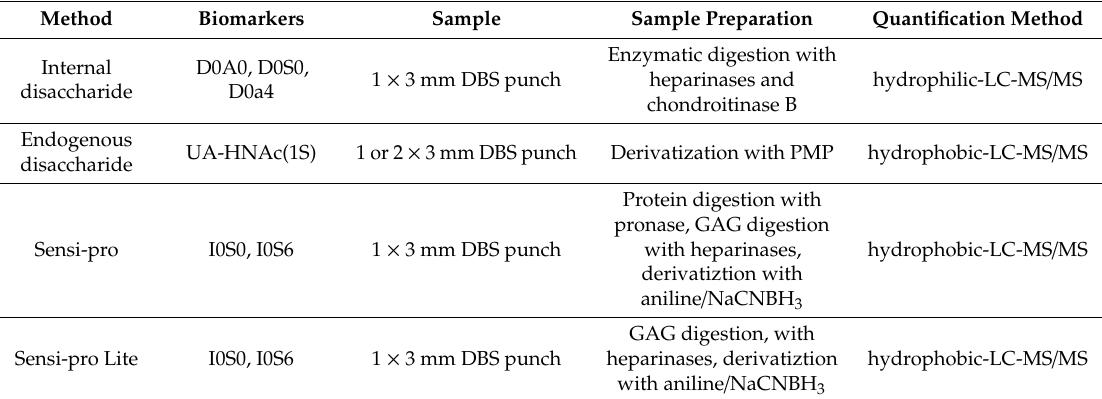
Table 1. Comparison of four glycosaminoglycans (GAG)-analysis